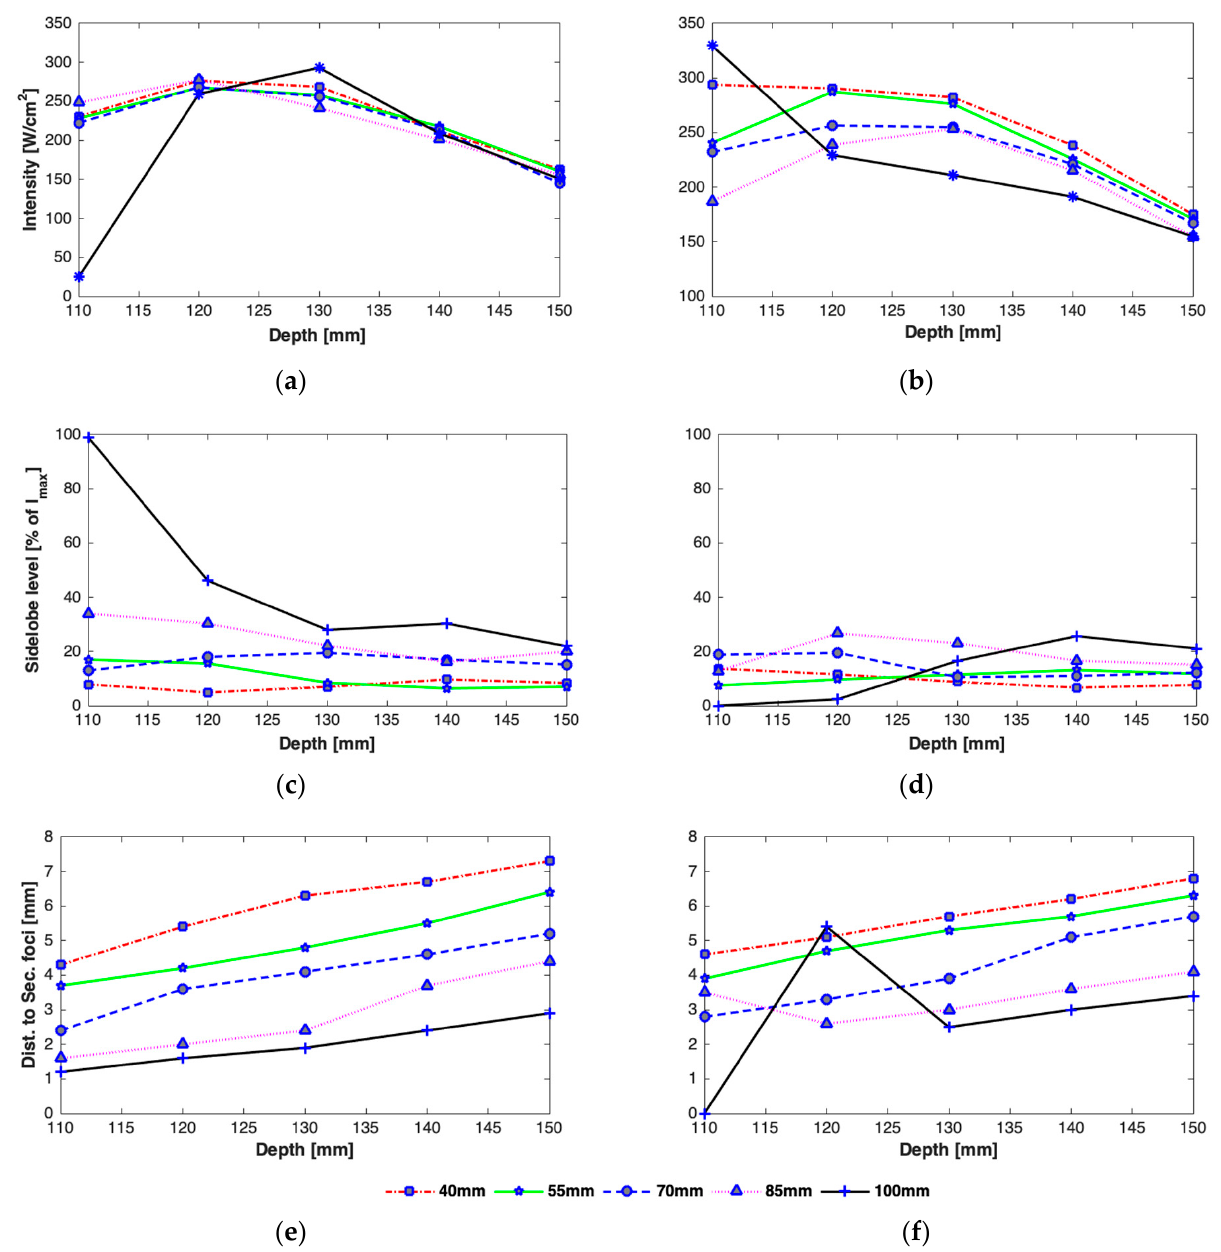
Figure 8. Effect of axial steering on the peak focal intensity ( a , b ), magnitude of secondary foci ( c , d ), and spacing between the main focus and secondary foci ( e , f ), when the beam axis is aligned with one of the ribs ( a , c , e ) and center of intercostal spacing ( b , d , f ), for rib cage positioned at 40 mm, 55 mm, 70 mm, 85 mm, and 100mm and for a nominal input acoustic power of 15